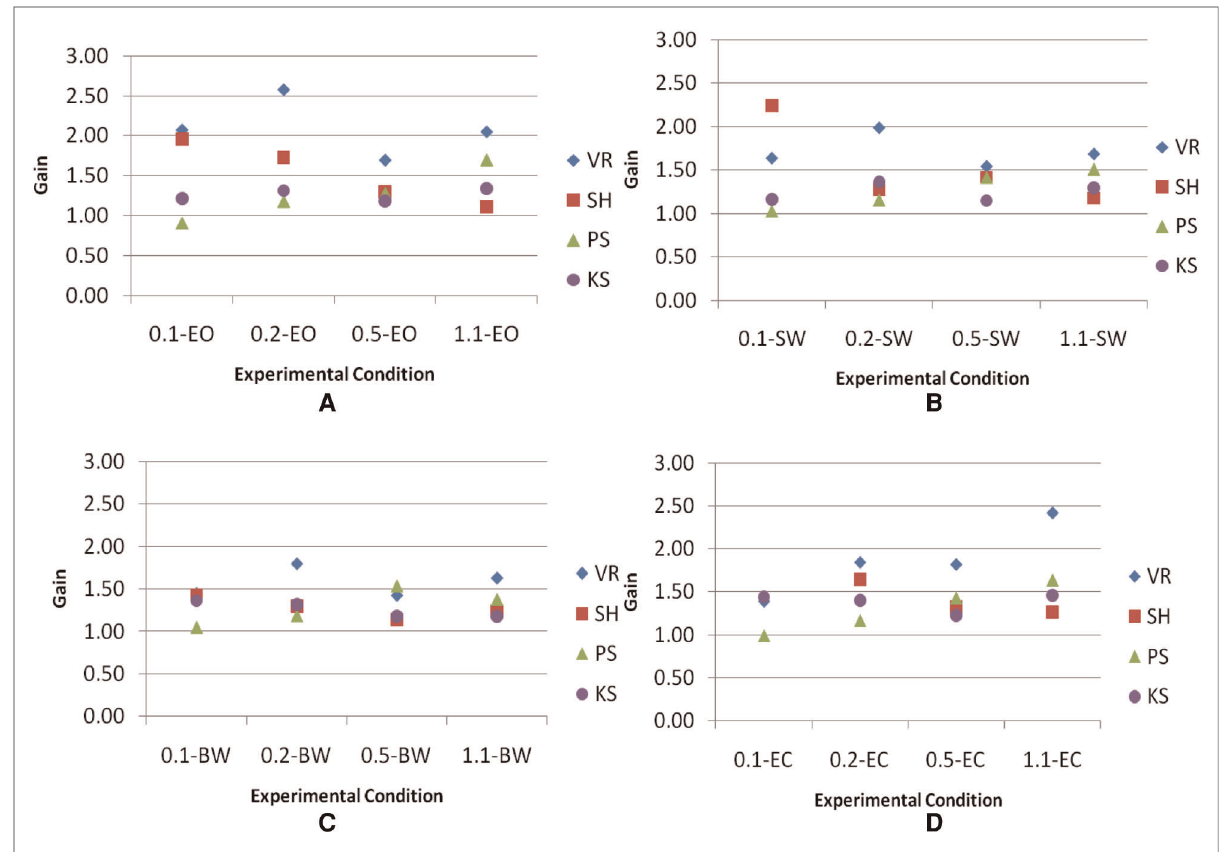
FIGURE 9 Gains of the head across frequencies in each visual condition. Visual conditions included here are ( A ) EO, ( B ) SW, ( C ) BW, and ( D )